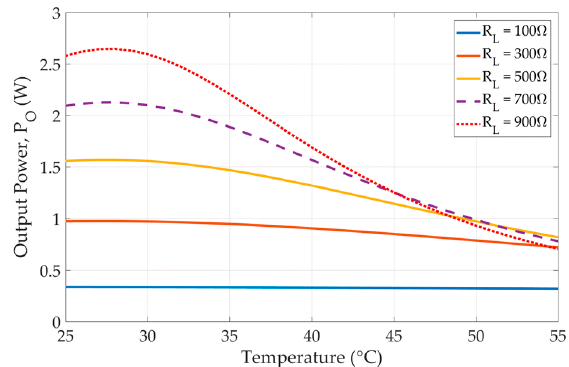
Figure 6. The variation in the output power per load in different temperatures.